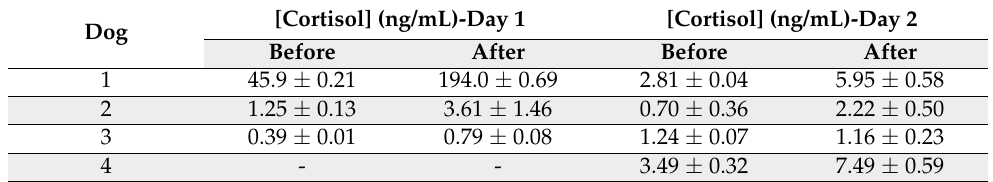
Table 2. Cortisol levels in IGDB saliva samples measured by the immunosensor. Dog Before After Before